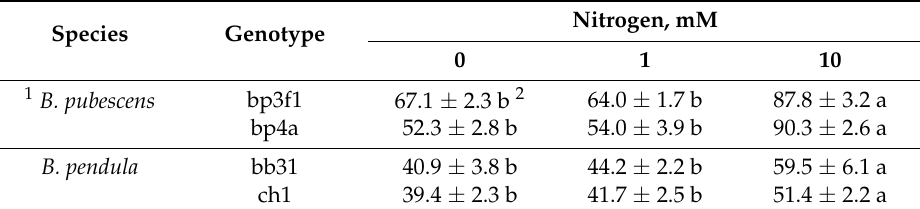
Table 1. Effect of nitrogen availability on growth (cm) of nontransgenic birch plants.